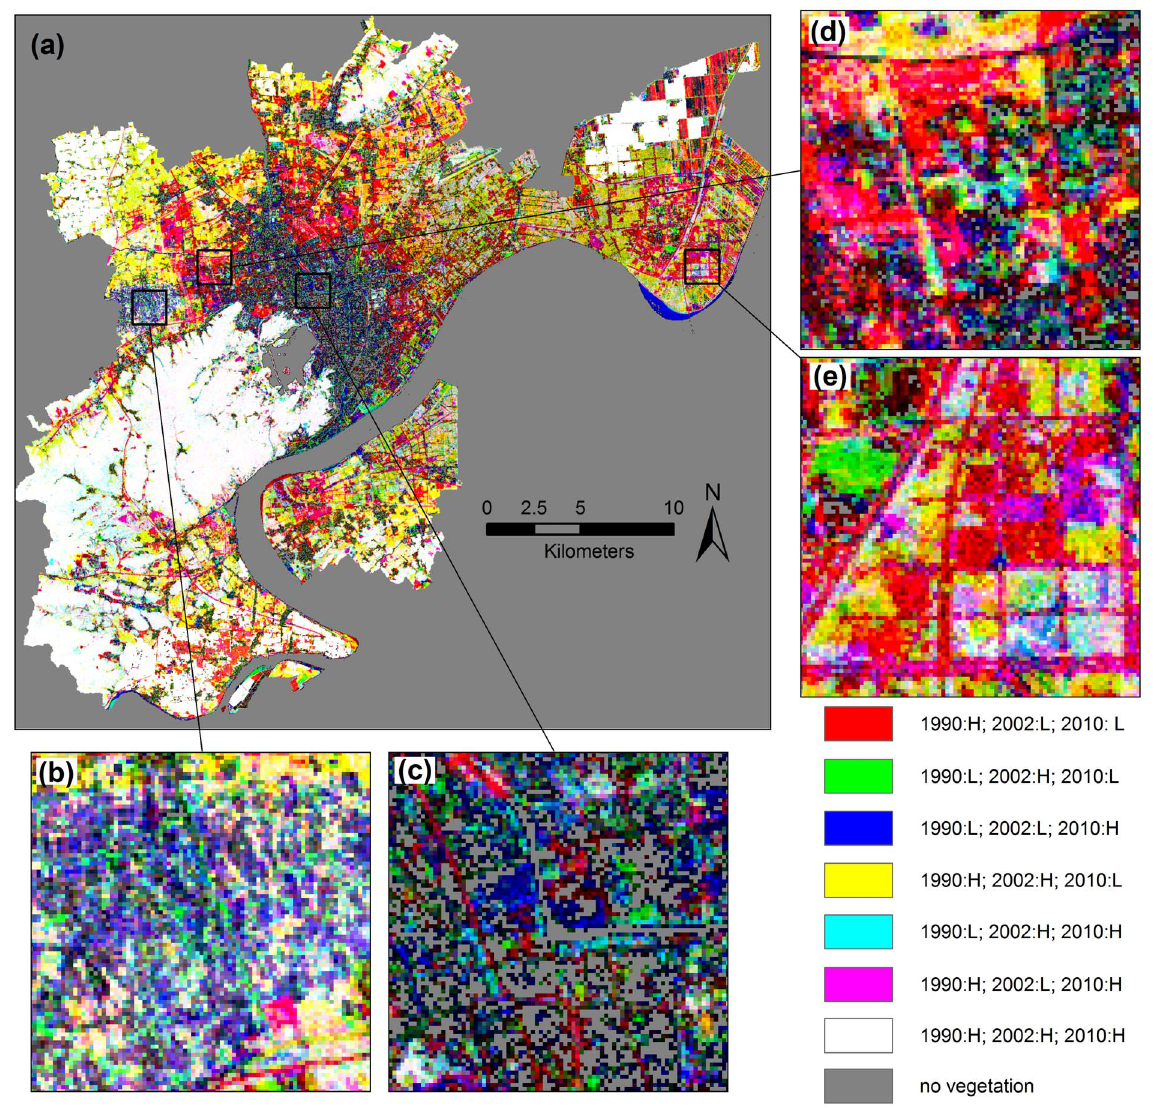
Figure 5. RGB color composite using vegetation fraction maps of 1990 (R), 2002 (G) and 2010 (B). The typical examples demonstrated are (a) the study area, (b) Xixi National Wetland Park, (c) the urban center, (d) residential communities and (e) the Xiasha suburban college town. Colors for the typical compositions of the vegetation fractions on the three dates are illustrated. H represents high vegetation fraction and L represents low vegetation fraction.